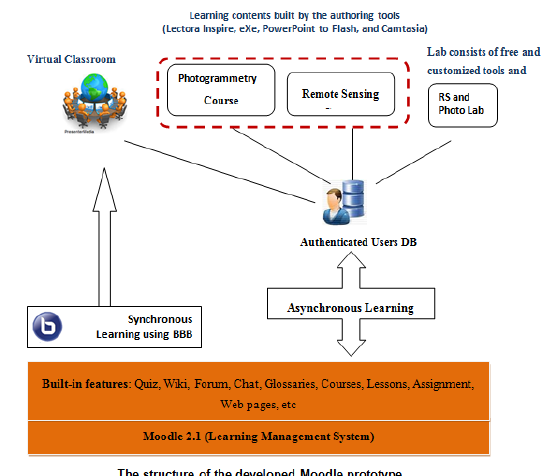
Figure 2: The structure of the developed Moodle prototype